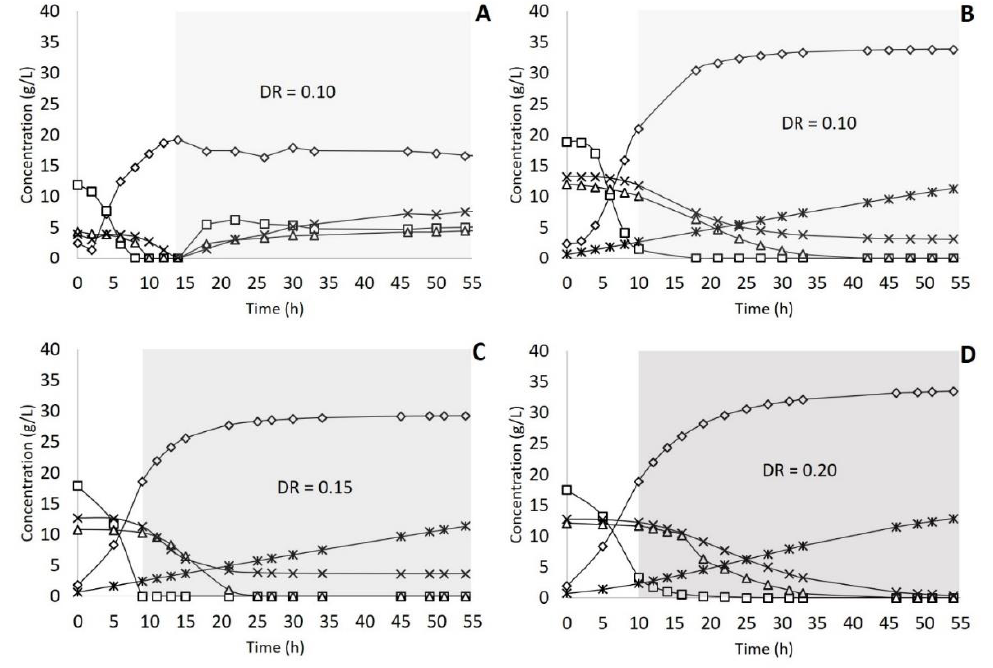
Figure 2. Continuous fermentation of sugar beet pulp (SBP) hydrolysate. ( A ) Continuous process (C1) without cell retention and dilution rate = 0.10 h − 1 ; ( B ) Continuous process (C2) with cell retention and dilution rate = 0.10 h − 1 ; ( C ) Continuous process (C3) with cell retention and dilution rate = 0.15 h − 1 ; ( D ) Continuous process (C4) with cell retention and dilution rate = 0.20 h − 1 ; (◊) Lactic acid; (□) Glucose; ( ∆ ) Xylose; ( × ) Arabinose; ( ∗ ) Biomass; DR = dilution rate.